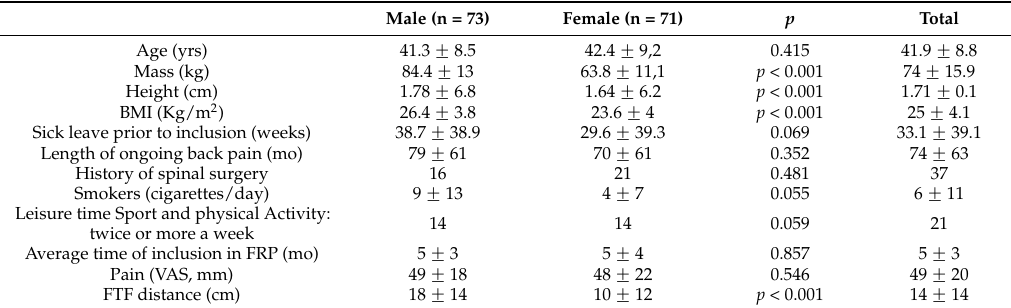
Table 1. Demographic data and clinical characteristics before